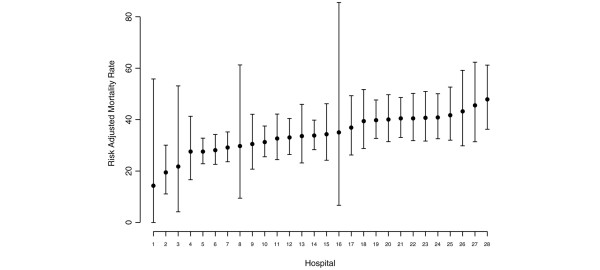
ICU-specific RAMRs for patients admitted with severe sepsis. Values denote the risk-adjusted mortality rate (RAMR) with 95% confidence interval for each of the 28 Dutch intensive care units (ICUs) participating in the study. The RAMR was calculated as follows: based on the case-mix correction model (which included the variables age, sex, SAPS II score, and number of dysfunctioning organ systems), the standardized mortality ratio (SMR) was calculated for each ICU by dividing the observed number of deaths by the number of deaths as expected by the model. The RAMR was subsequently calculated by multiplying the SMR with the overall mean mortality rate in the population of patients admitted with severe sepsis. Values are based on all patients admitted with severe sepsis between 1 January 2003 and 30 June 2005.